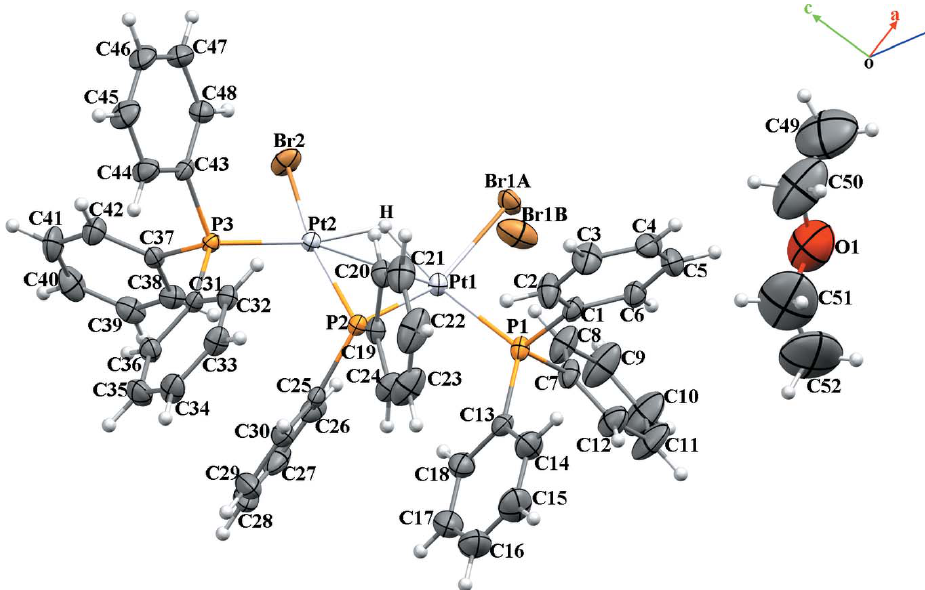
Figure 1 The asymmetric unit of title compound, showing the atom-numbering scheme. Displacement ellipsoids are drawn at the 50% probability